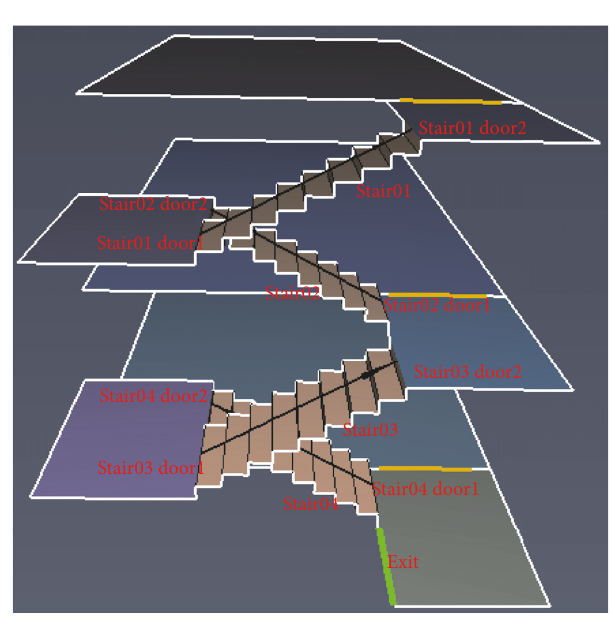
Figure 8: The staircase and exit of the building.